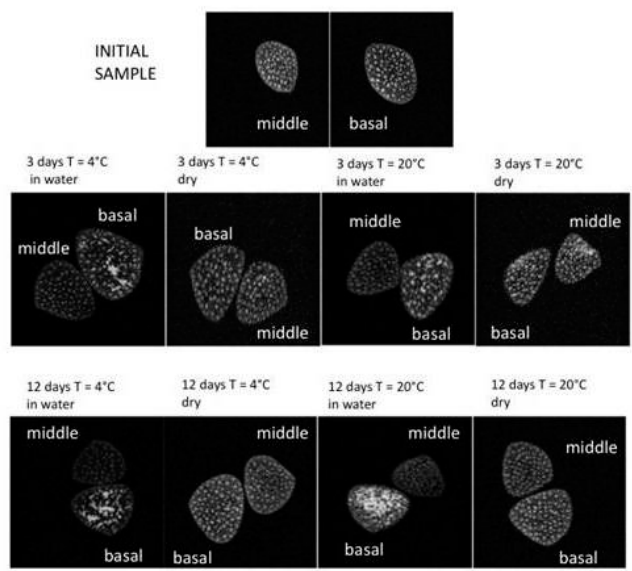
Fig. 2 - MSME MRI images of flowers, middle and basal sections. On top, initial samples. Ten images were taken for each sample at each sampling time. The reported images are representative of the pool of 10 for each sample, which showed similarity of